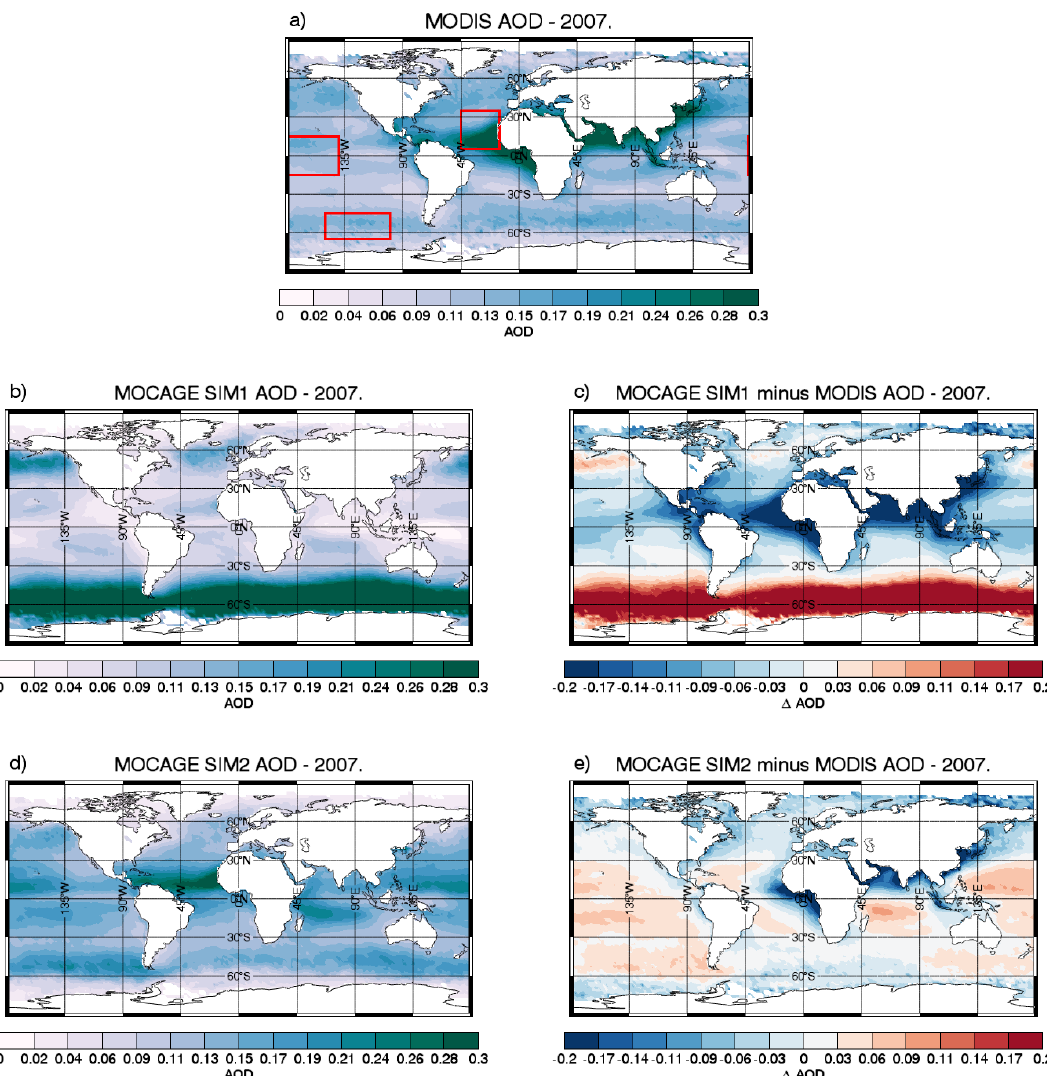
Figure 4. Global, mean aerosol optical depth at 550nm for the year 2007 from MODIS (Aqua + Terra) (a) , SIM1 (b) , SIM2 (d) , and the difference between MODIS observations and model simulations (c , e) . The descriptions of the model simulations are in Table 2. The boxes in panel (a) correspond to the regions used in Fig.